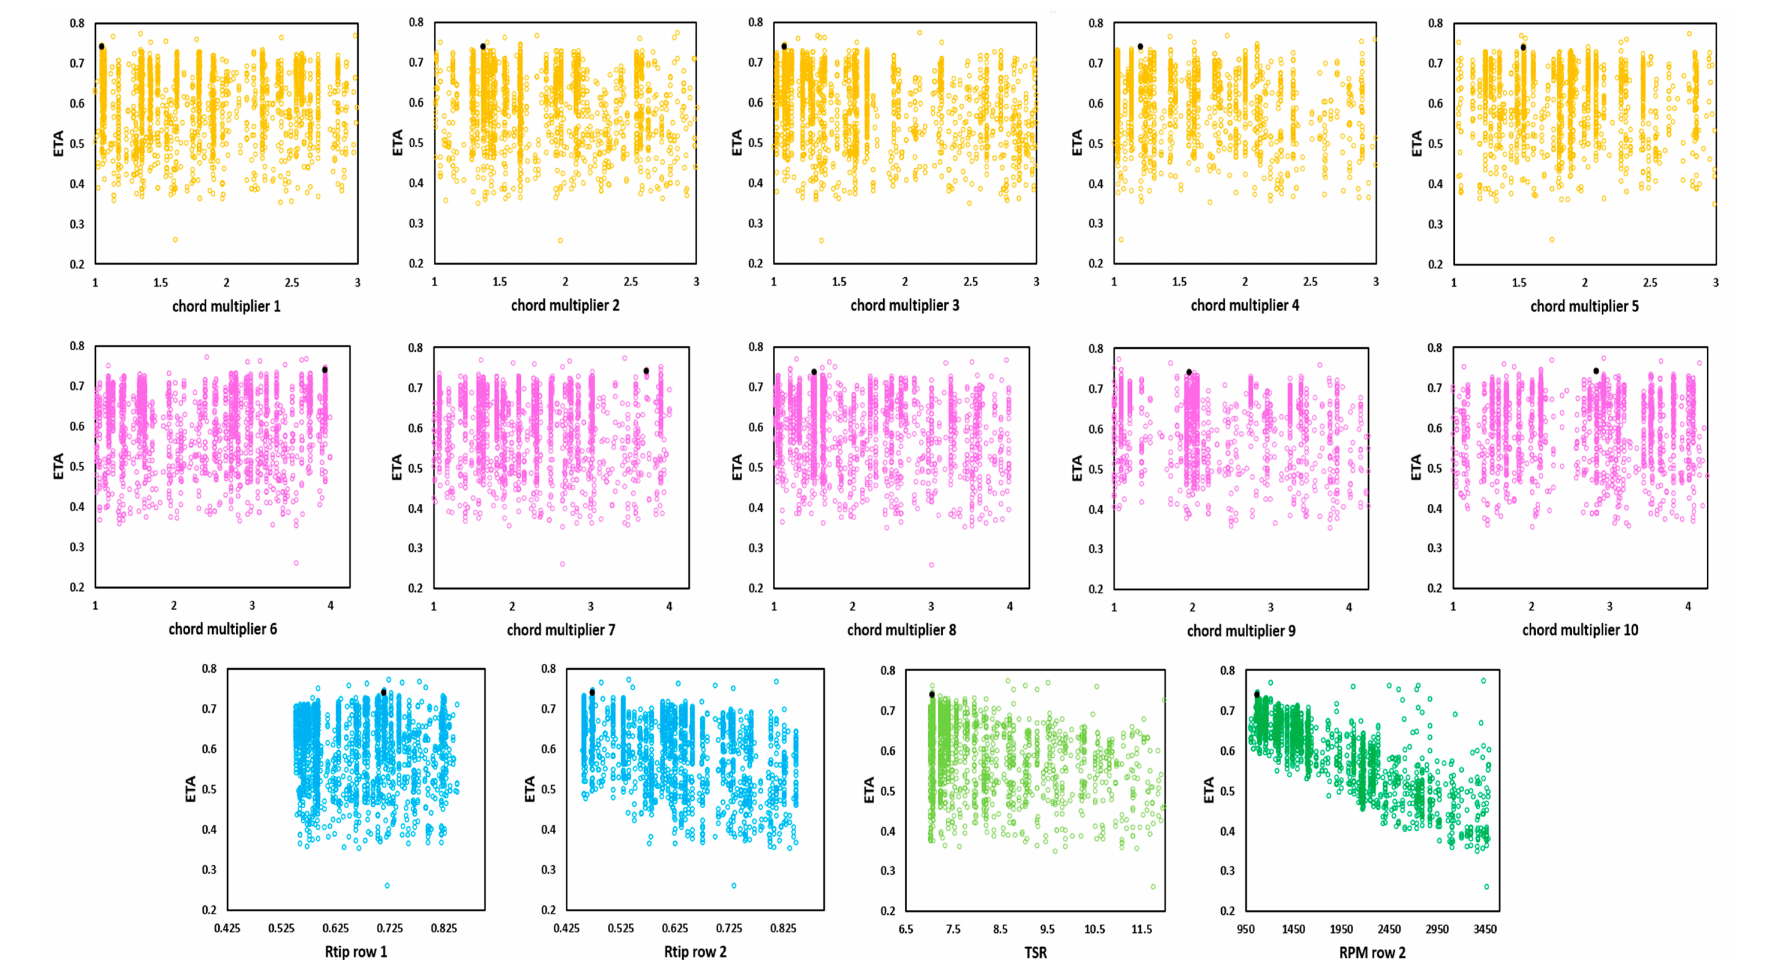
Figure 32. Objective function vs. parameters and optimum value represented as a black